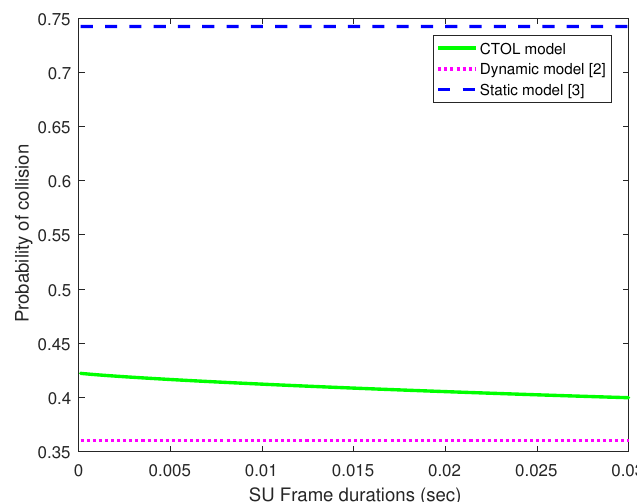
Figure 8. The probability of collisions for the CTOL model, dynamic model, and static model.